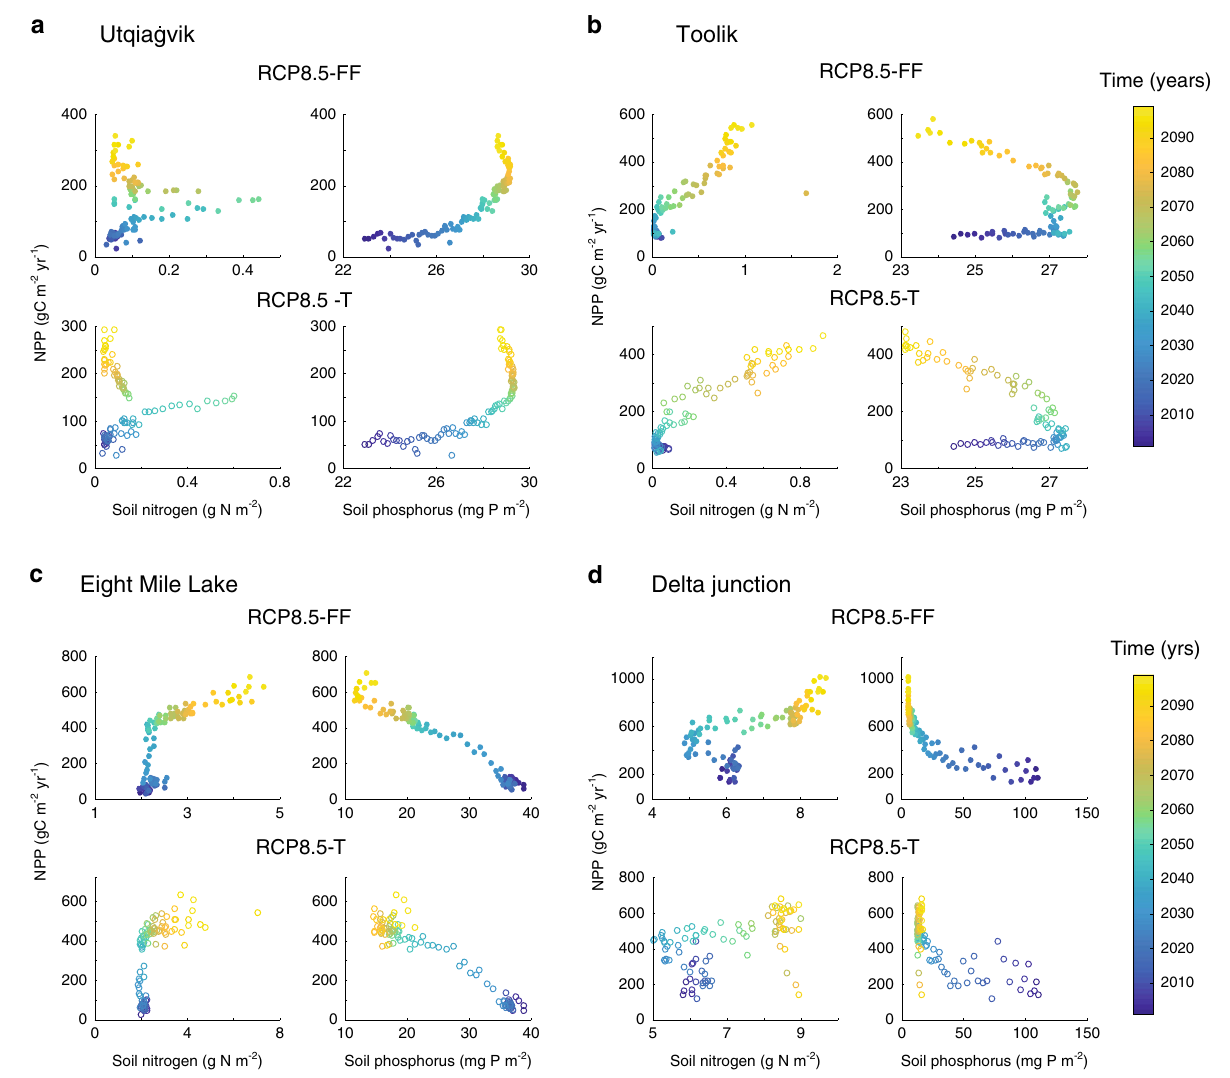
Fig. 5 Nitrogen limitation constrains net primary productivity at most sites, but phosphorus appears to constrain net primary productivity at Utqia ġ vik. Net primary productivity (calculated as an annual mean value in g C m − 2 yr − 1 ) plotted against soil availability of nitrogen (NH 4 + + NO 3 − in g N m − 2 ) and phosphorus (g P m − 2 ) at a Utqia ġ vik, b Toolik, c Eight Mile Lake, and d Delta Junction. Phosphorus represents the modeled forms of SOM-P, labile-PO 4 3 − , and mineral-associated PO 4 3 − available for plant and microbial uptake. NPP generally shows a positive relationship with soil nitrogen. However, a more complex relationship with phosphorus (a higher uptake of P towards the end of the century), suggests the possibility of emergent P-limitation over time. Plots show RCP8.5-FF ( fi lled circles) and RCP8.5-T (un fi lled circles). The plots are color-coded by time (right